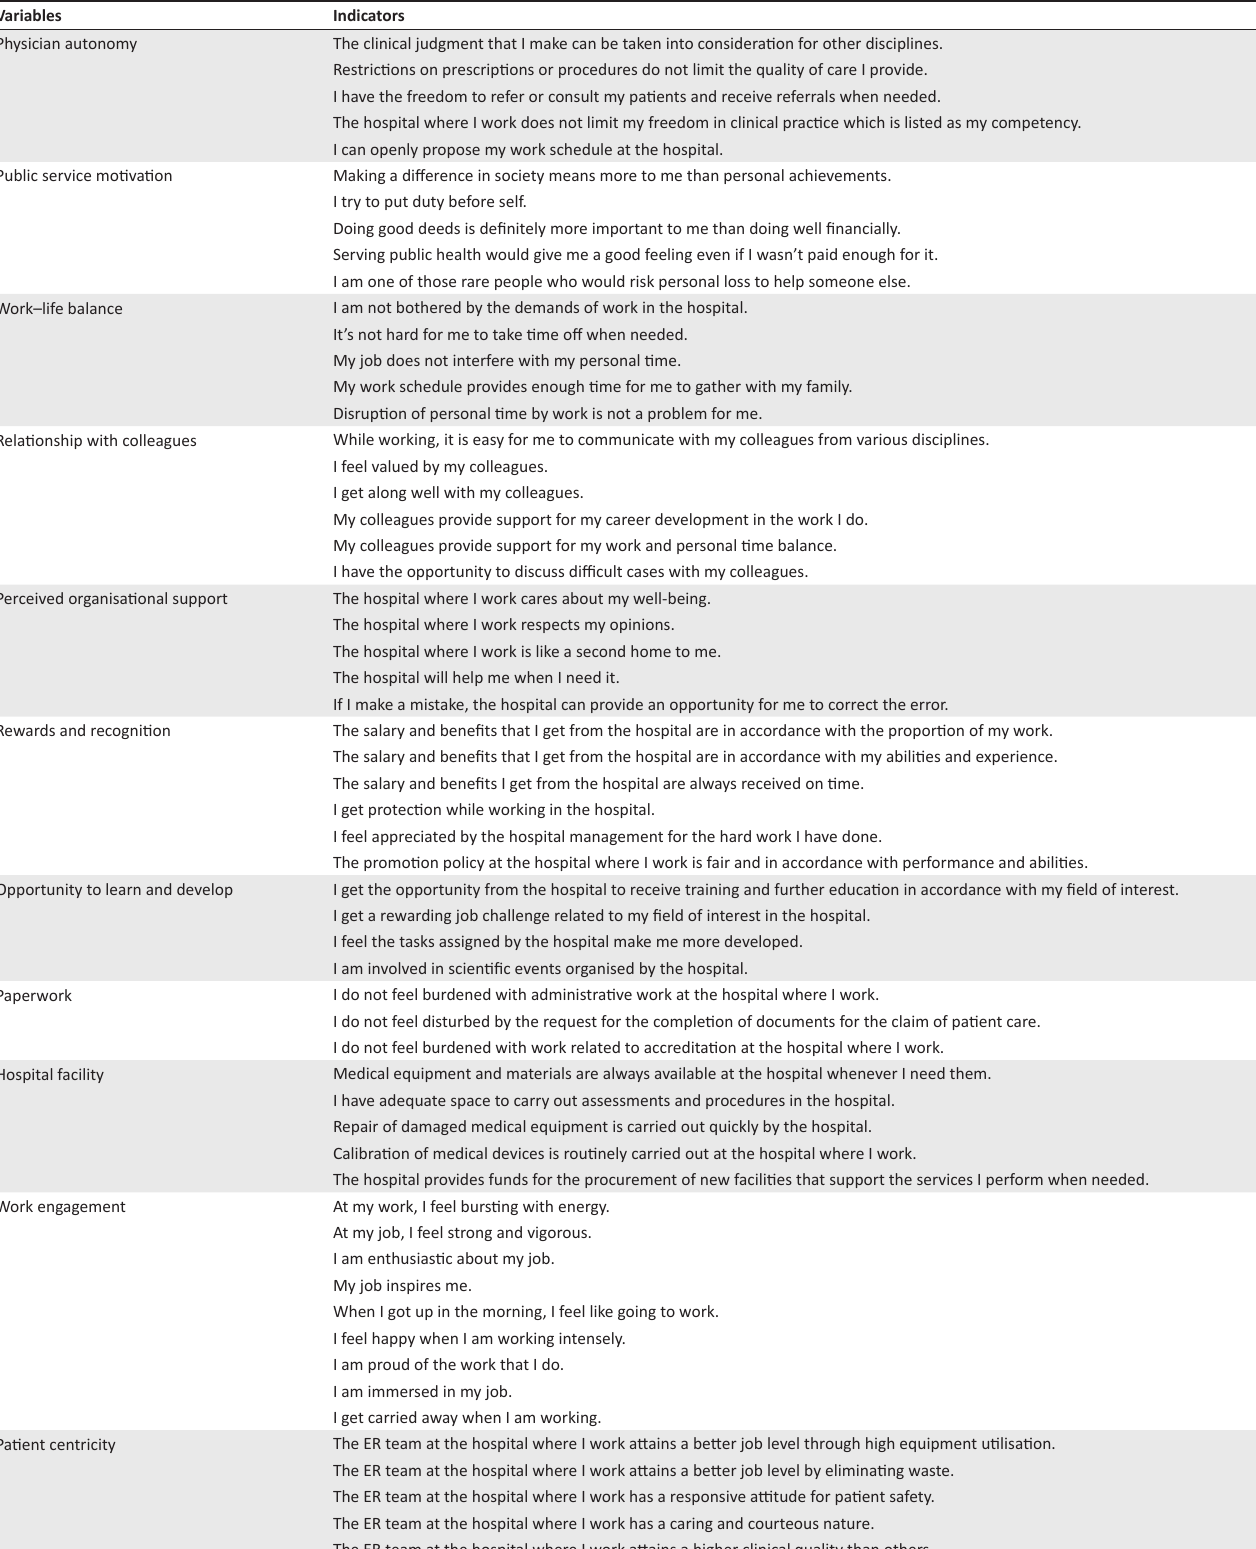
TABLE 1-A1: Measurement of work engagement and patient centricity. Variables